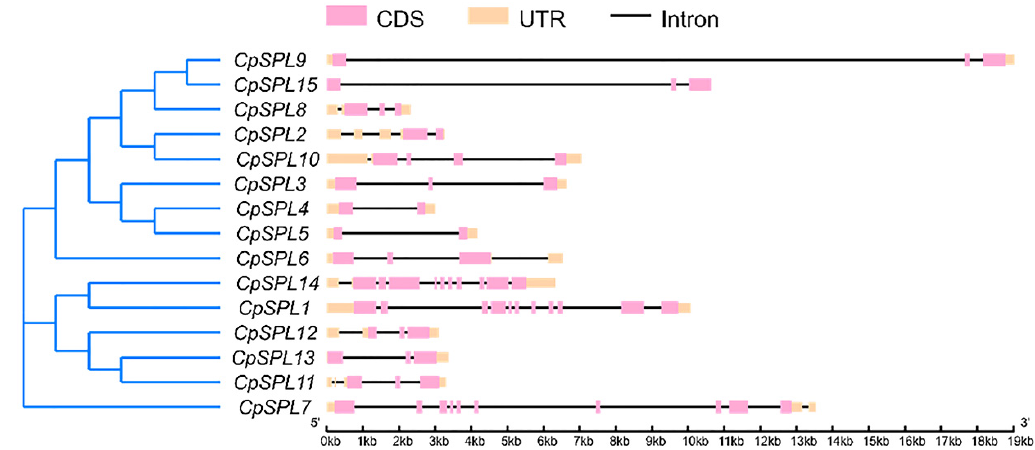
Figure 2. Exon–intron organization structures of 15 SPL genes in Codonopsis pilosula . Exons are represented by pink rec- tangles, introns are represented by black lines, UTRs are represented by orange rectangles.